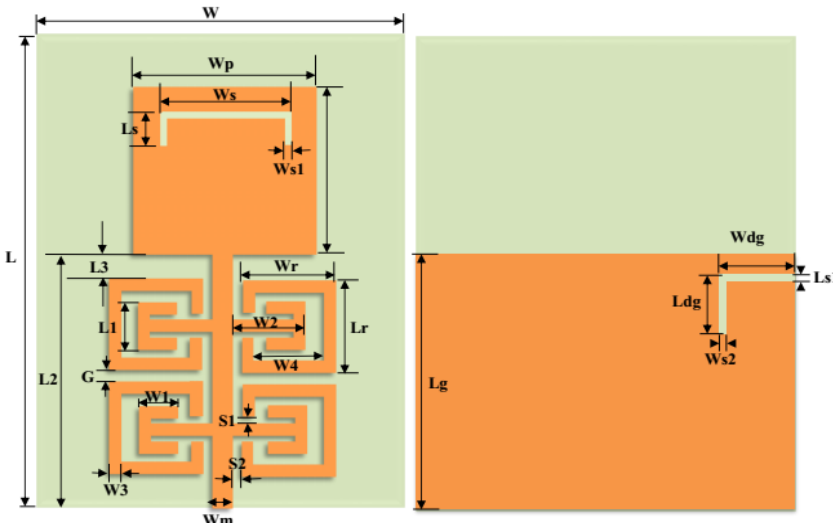
Figure 5. The proposed filter-antenna structure with its optimised dimensions. Table 1. The optimised dimensions of the proposed filtering antenna (in mm).